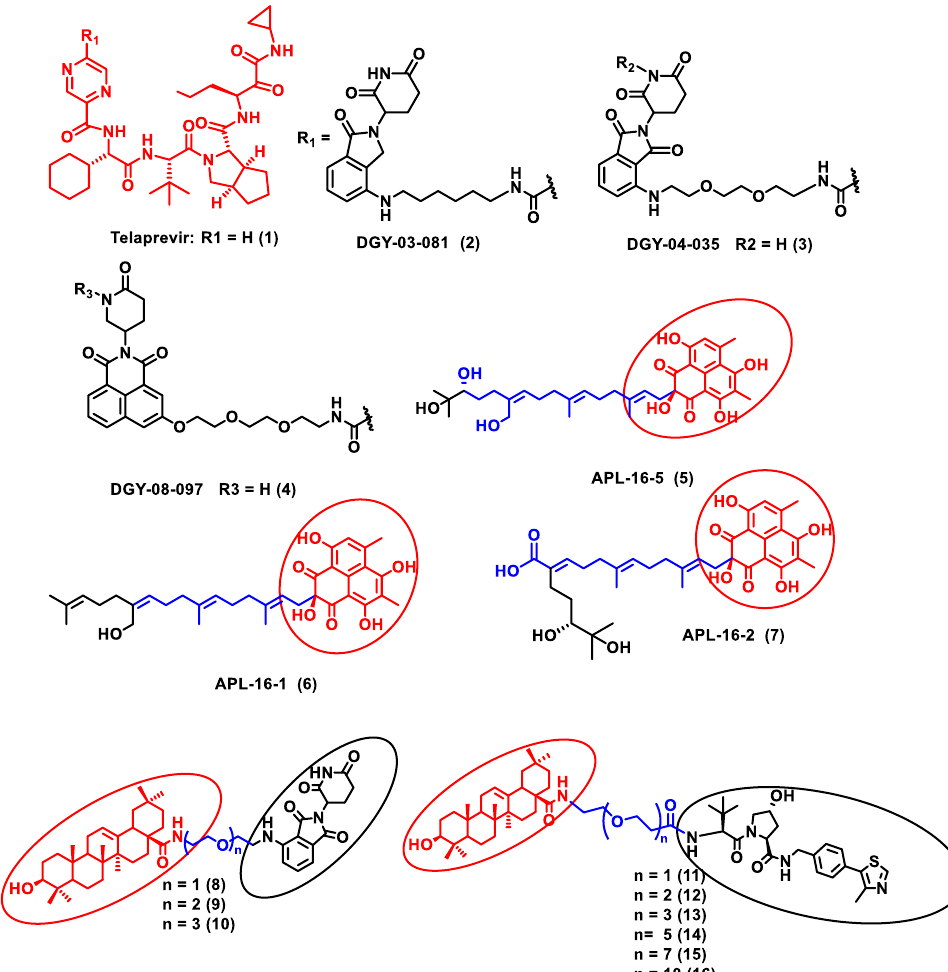
Figure 2. Structures of the PROTAC molecules used for the degradation of viral proteins. The red circle indicates the POI ligand. The blue wavy line indicates the linker, and the black circles indicate the E3 ligand moiety.